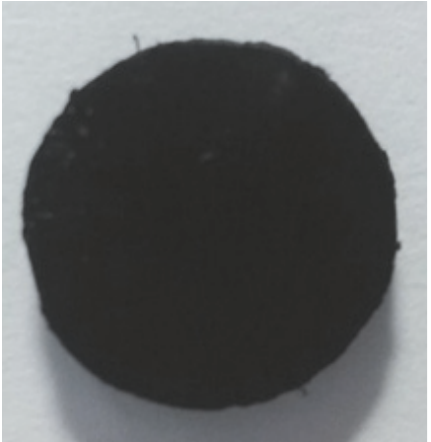
Figure 1: High-damping rubber